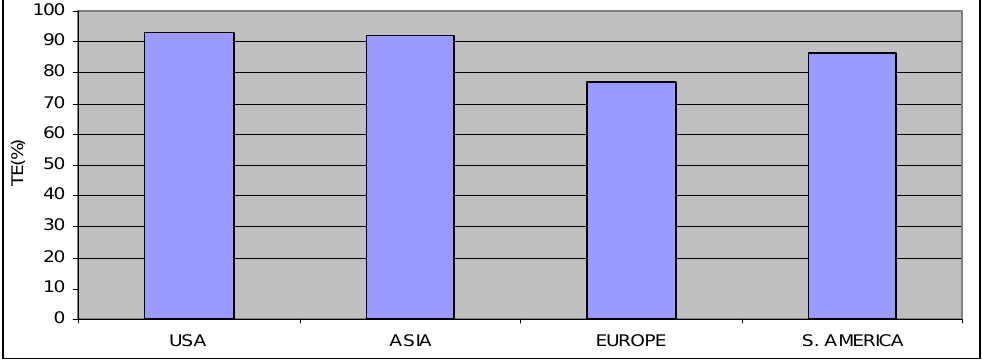
Figure 1. Average Technical Efficiency (%) by Continent of Origin